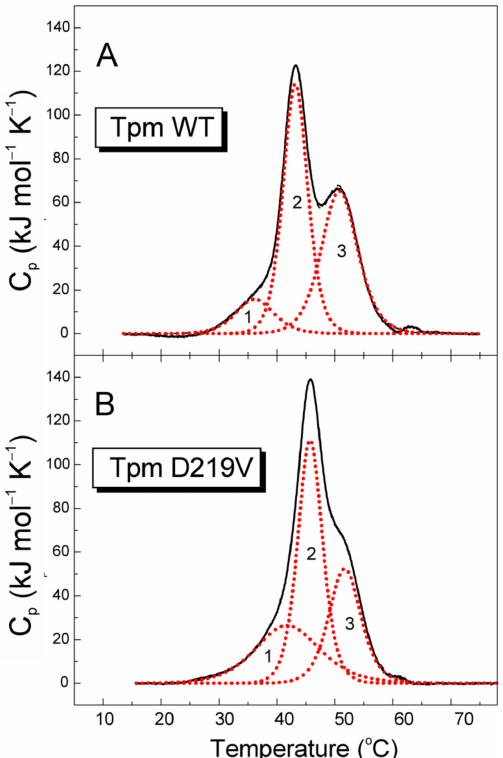
Figure 2. Temperature dependences of the excess heat capacity ( C p ) monitored by DSC and deconvo- lution analysis of the heat sorption curves for WT Tpm ( A ) and Tpm with mutation D219V ( B ). Solid lines represent the experimental curves after the subtraction of instrumental and chemical baselines, and dotted red lines represent the individual thermal transitions (calorimetric domains) obtained from fitting the non-two-state model [25] to the